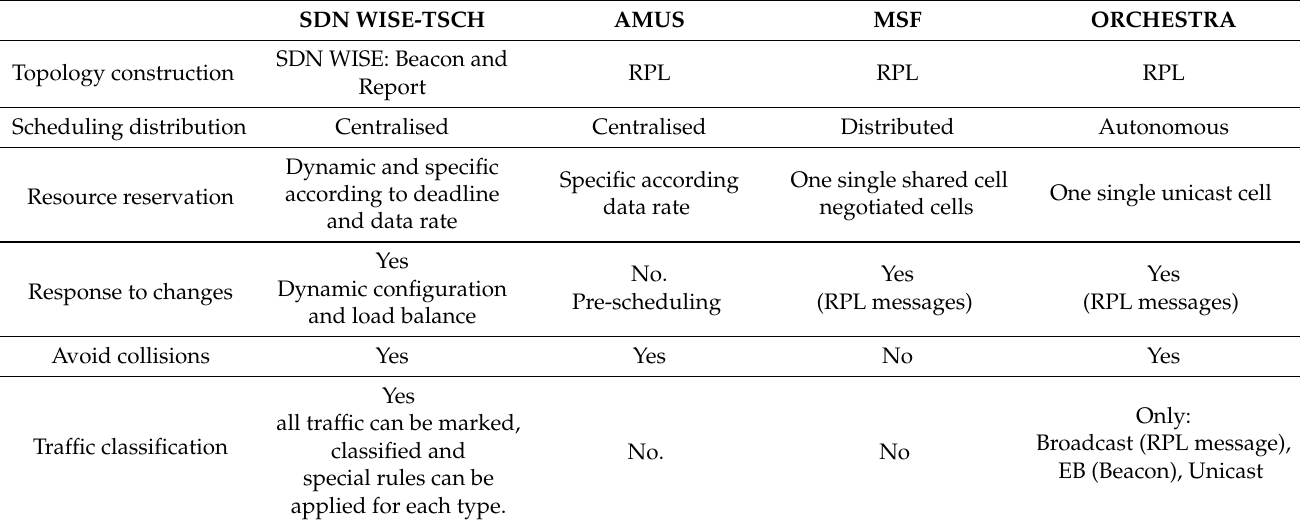
Table 1. Summary of features for each of the TSCH